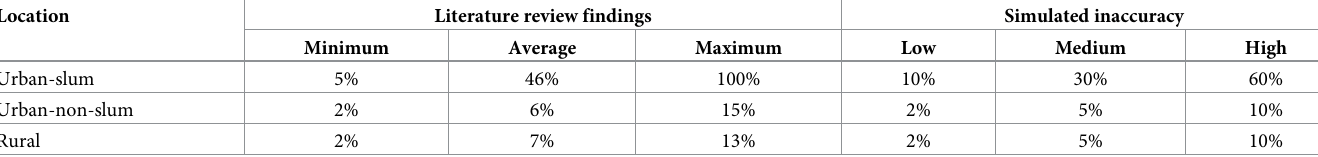
Table 1. Range and average percent of population missing from LMIC censuses based on literature review. Location